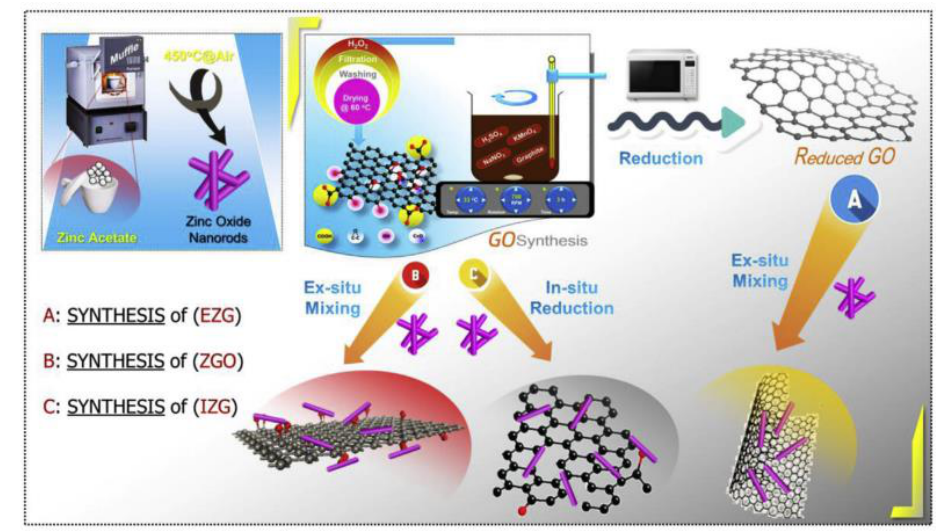
Figure 9. The synthesis of zno nanorods, go reduced go and their nanocomposites.